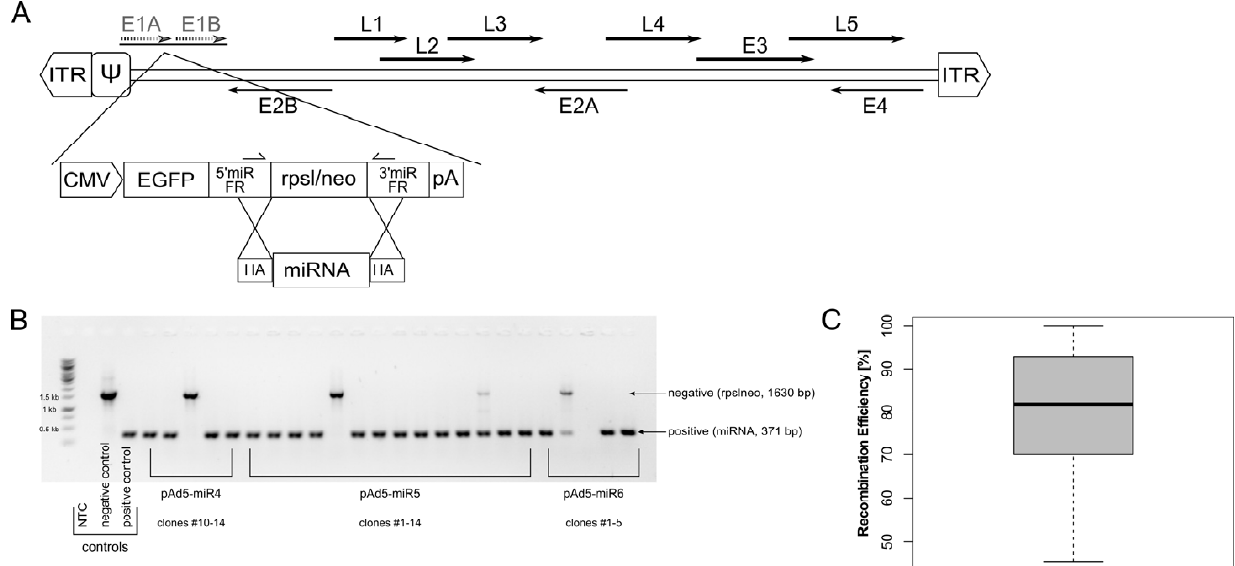
Figure 1 . An adenoviral vector used for expression of miRNAs. ( A ) An expression cassette encoding for EGFP reporter gene, and a pre-miRNA driven by a CMV promoter was inserted in E1-deleted region of Ad5. Subsequently, miRNA sequence was replaced with a counter-selection marker (rpsl/neo) enabling fast and efficient insertion of any miRNA of choice via homologous recombina- tion. Primer located in 5’- and 3 ′ -miR flanking regions were used to screen for positive clones after recombination. ( B ) Primers located within the 5’- and 3 ′ -miR flanking region were employed to screen for miRNA insertion in a diagnostic colony PCR. Constructs harbouring the rpsl/neo counter selection cassette resulted in a 1630-bp PCR fragment, whereas successful miRNA insertion resulted in a 371-bp PCR. Ad-miRNA-rpslneo and Ad-miRscr served as negative and positive control, re- spectively. ( C ) Recombination efficiency was determined by inserting 13 different miRNAs; number of positive clones was ascertained with PCR. On average, miRNAs could be inserted with an effi- ciency of 80.6 ± 16.7%. ITR, inverted terminal repeats; ψ , packaging signal; E1–E4, early genes; L1– L5, late genes; 5’-/3’- miR FR, 5’-/3’- miRNA flanking regions; HA, homology arms; NTC, no tem- plate control.